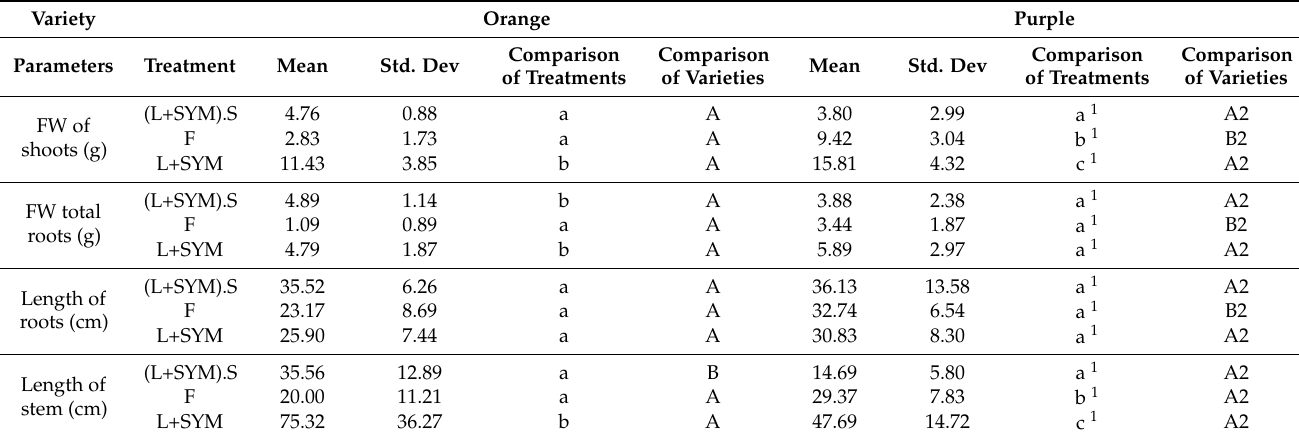
Comparison Comparison Comparison Comparison Mean Std. Dev of Treatments of Varieties of Treatments of Varieties